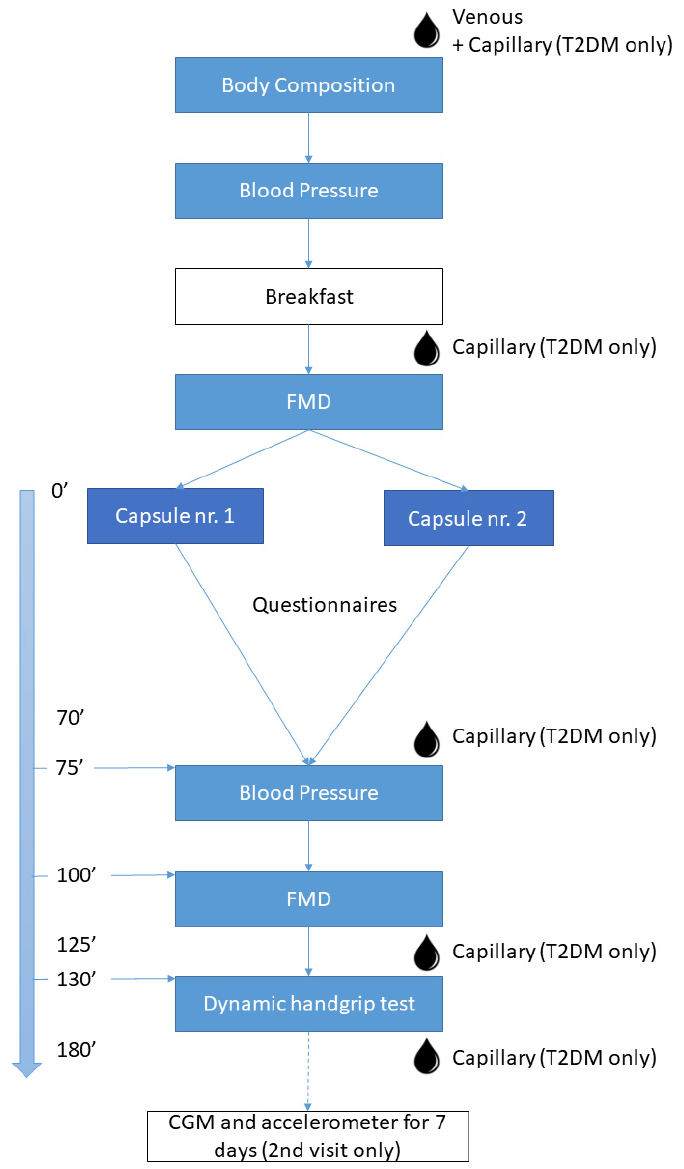
Figure 1. Flowchart. Legend: FMD = flow-mediated dilation test; CGM = continuous glucose moni- toring system.